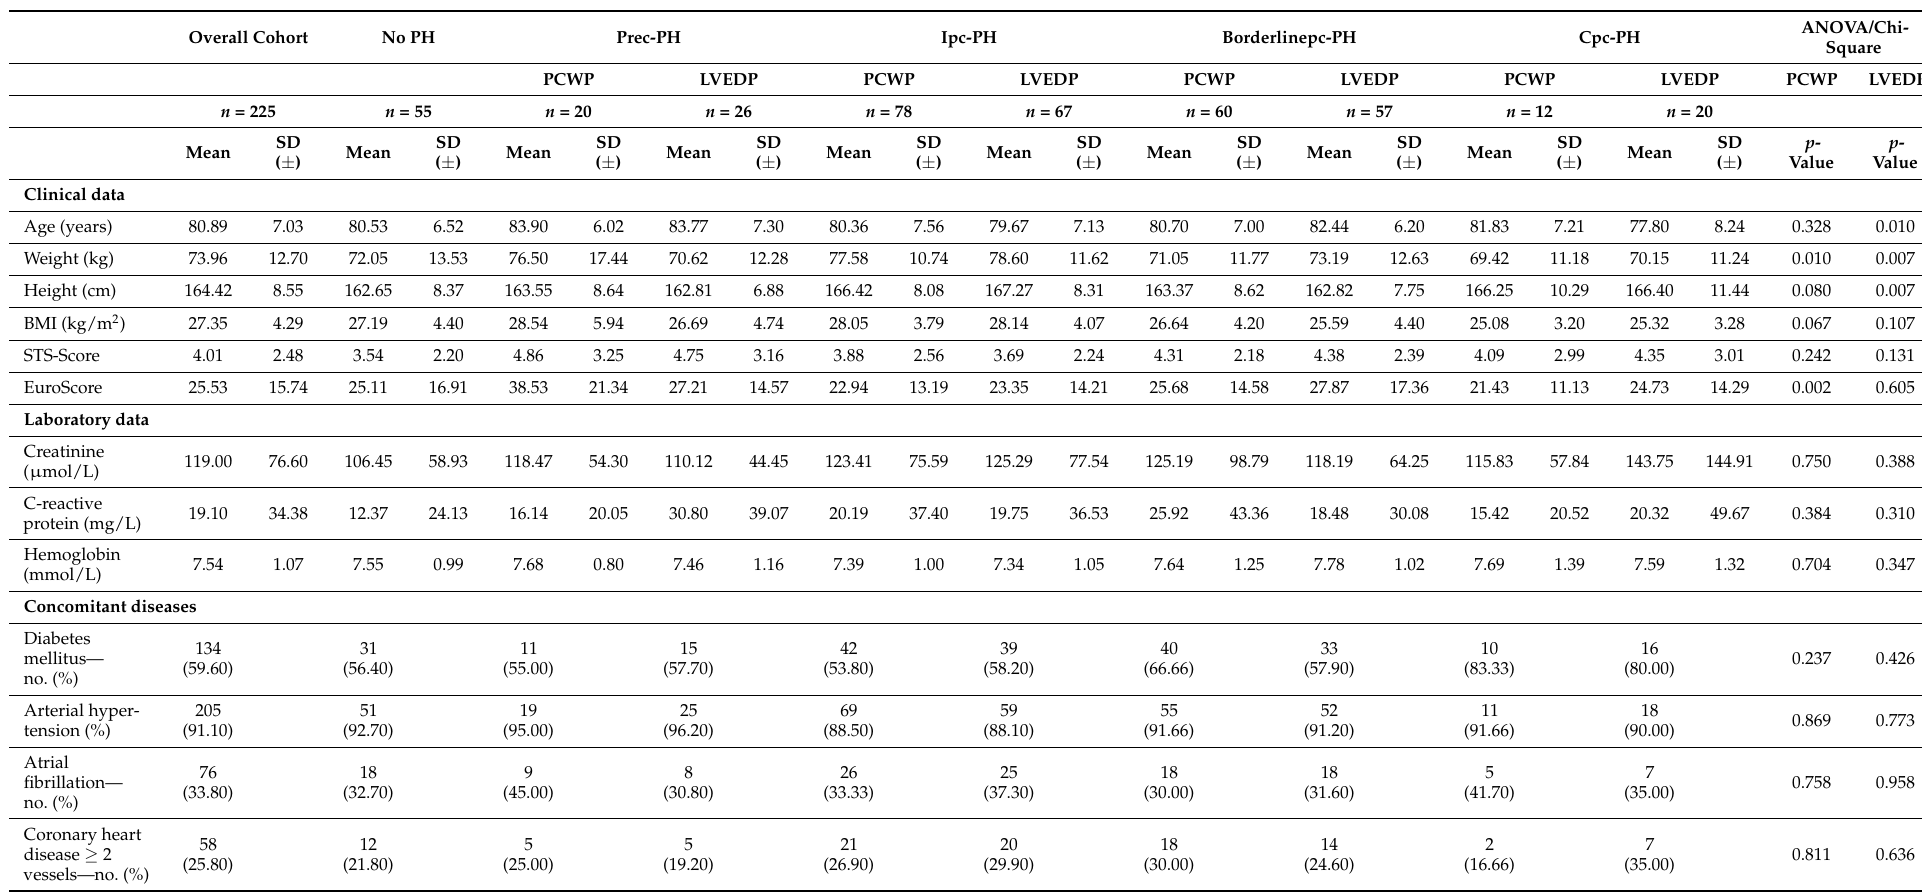
Table 1. Clinical and laboratory data, echocardiographic measurements, invasive hemodynamic profile and procedural data of study cohort by PH subtypes. BMI: body mass index; EF: ejection fraction; LVEDD: left ventricular end-diastolic diameter; LVESD: left ventricular end systolic diameter; sPAP: systolic pulmonary arterial pressure; AVA: aortic valve area; AV max: maximal velocity over aortic valve; AV dpmax: maximal pressure gradient over aortic valve; AV dpmean: mean pressure gradient over aortic valve; mPAP: mean pulmonary arterial pressure; dPAP: diastolic pulmonary arterial pressure; PCWP: pulmonary capillary